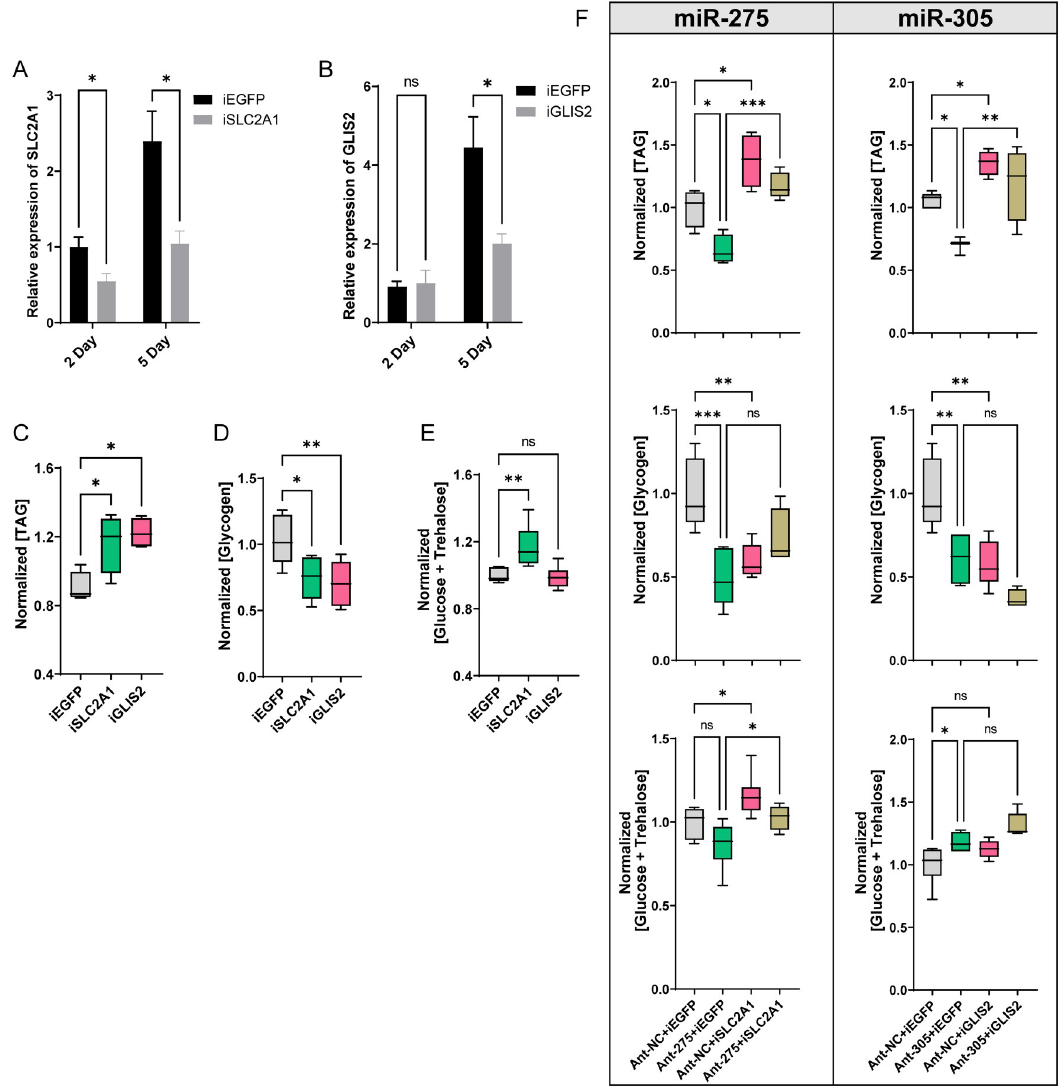
Fig 7. Knockdown of SLC2A1/GLIS2 partially rescues metabolic phenotype defects in antagomiR-treated flies. (A-B) RNAi knockdown efficiency of SLC2A1 and GLIS2 at 2 days and 5 days post dsRNA injection by qRT-PCR. (C-E) Effects of dsRNA treatment on the contents of TAG (C), glycogen (D), and total sugar (glucose plus trehalose) (at 5 days post-injection) (G). (F) Metabolic phenotypes of antagomiR-treated flies in rescue experiments. The experiments were performed by co-injecting dsRNA and antagomiR with co-injection of dsEGFP and the antagomiR-control (Ant-NC) as a negative control. Left panel represents the rescue for miR-275 deletion, and right panel for miR-305 deletion. Data represent 10 biological replicates for each sample. One-way ANOVA was performed to determine statistically significant differences. � , P < 0.05; �� , P < 0.01; ��� , P < 0.001, NS, not